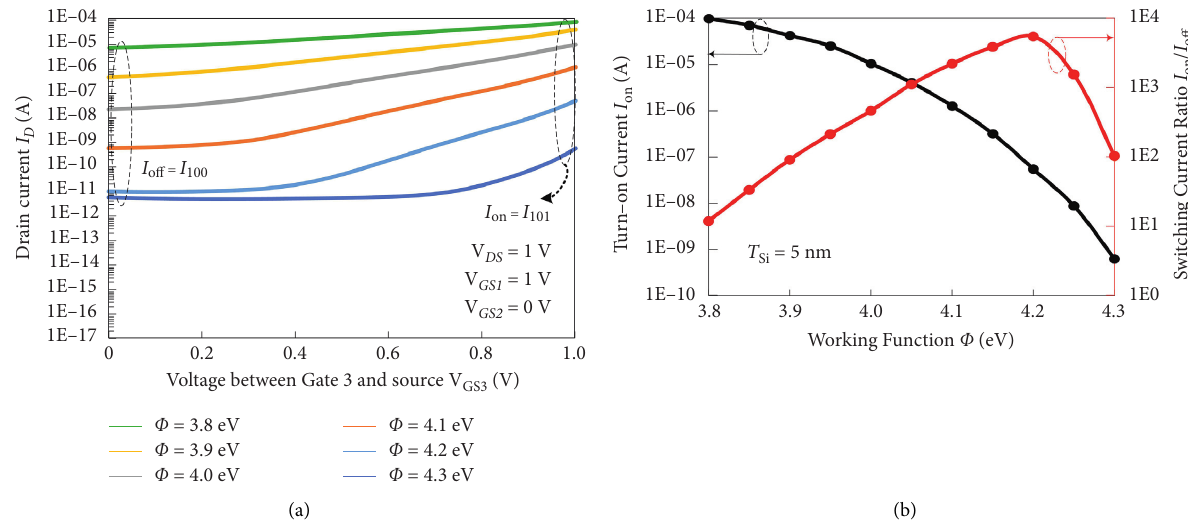
Figure 9: (a) I D - V GS3 characteristics of the Ti-TFET with different work functions ( Φ (b) turn-on current and I on / I off with different work functions.